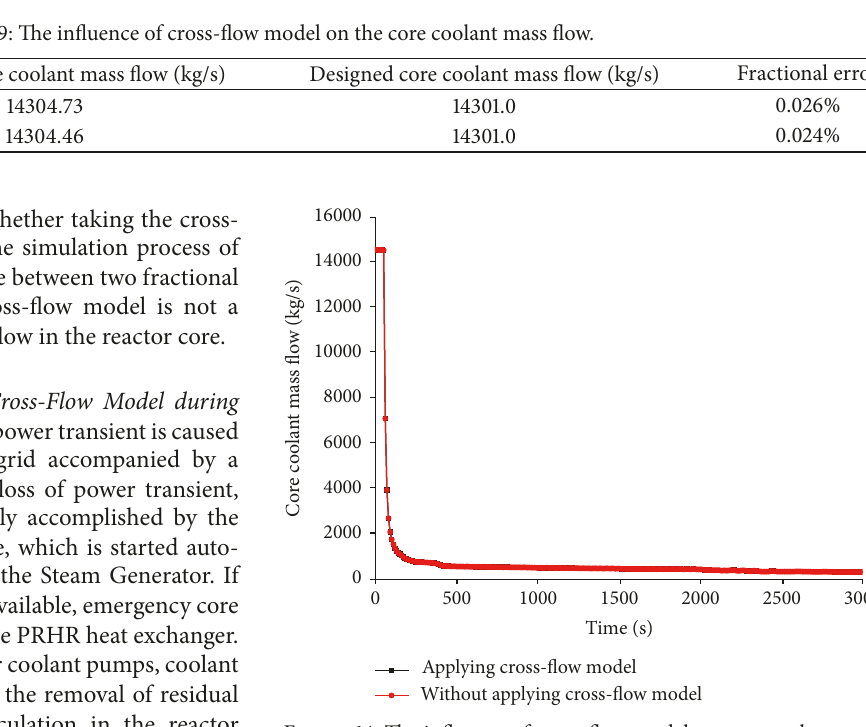
Figure 14: The influence of cross-flow model on core coolant mass